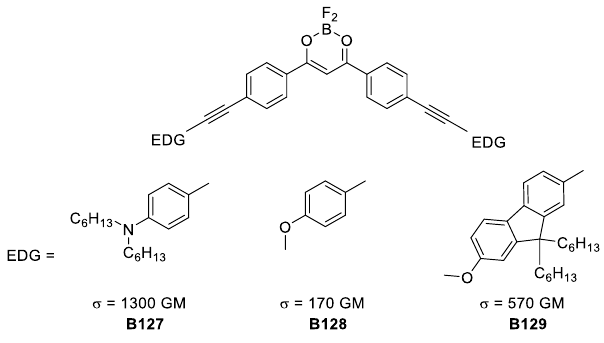
Figure 38. V-shaped boron-based, BF 2 -coordinated hydroxyketone complexes with TPA response.